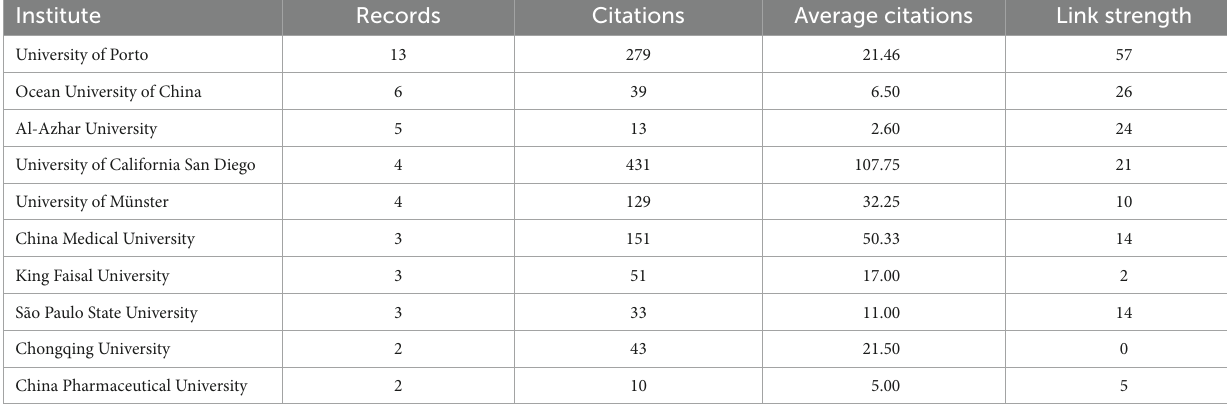
TABLE 2 Analysis of the output and citations of the top 10 institutions.